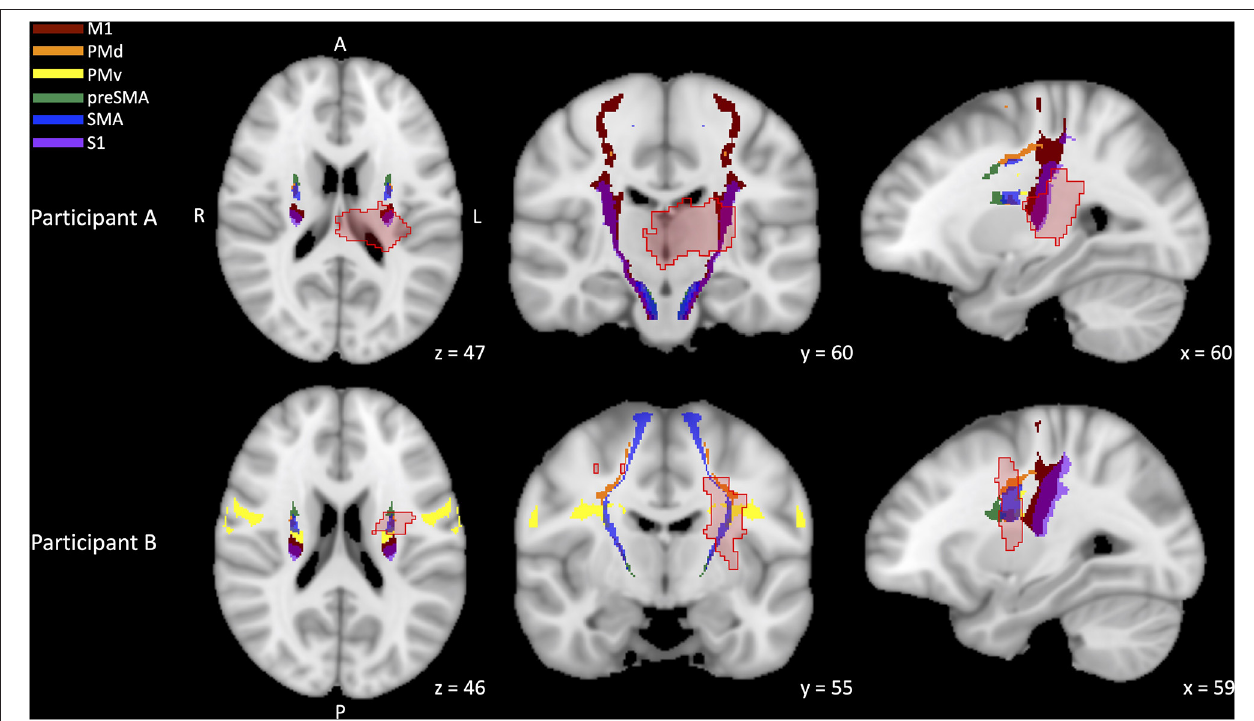
FIGURE 4 | Representative stroke lesions and sensorimotor area tract template (SMATT) corticospinal tract (CST) templates. CST templates have been differentiated by contributing region: primary motor cortex (M1, dark red), dorsal premotor cortex (PMd, orange), ventral premotor cortex (PMv, yellow), pre-supplementary motor cortex (preSMA, green), supplementary motor cortex (SMA, blue), primary somatosensory cortex (S1, purple). Stroke lesions are depicted in light red with dark red outline. Participant A [top (right, middle, left)] achieved a PUE outcome in the Good category. Participant B bottom (right, middle, left) achieved a PUE outcome in the Limited category. Right, Middle, and Left slices depict the axial, coronal, and sagittal slices, respectively. Both individuals had similar whole CST lesion overlap (A = 9.51%, B = 11.97%) but participant A had higher relative contribution of M1 CST lesion overlap (A M1 overlap = 18.87%, participant B M1 overlap =